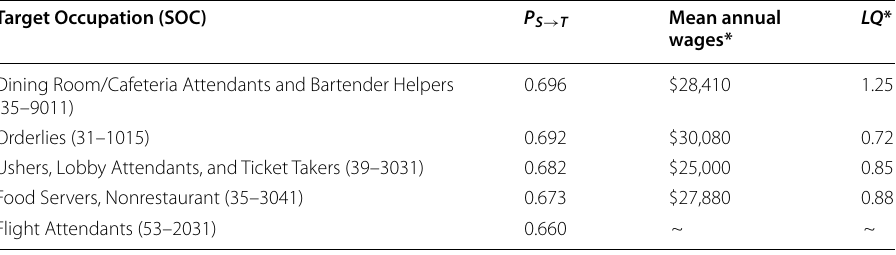
* Taken from the 2018 OEWS by MSA (U.S. Bureau of Labor Statistics 2018) ~ Data not disclosed for Washington, DC MSA